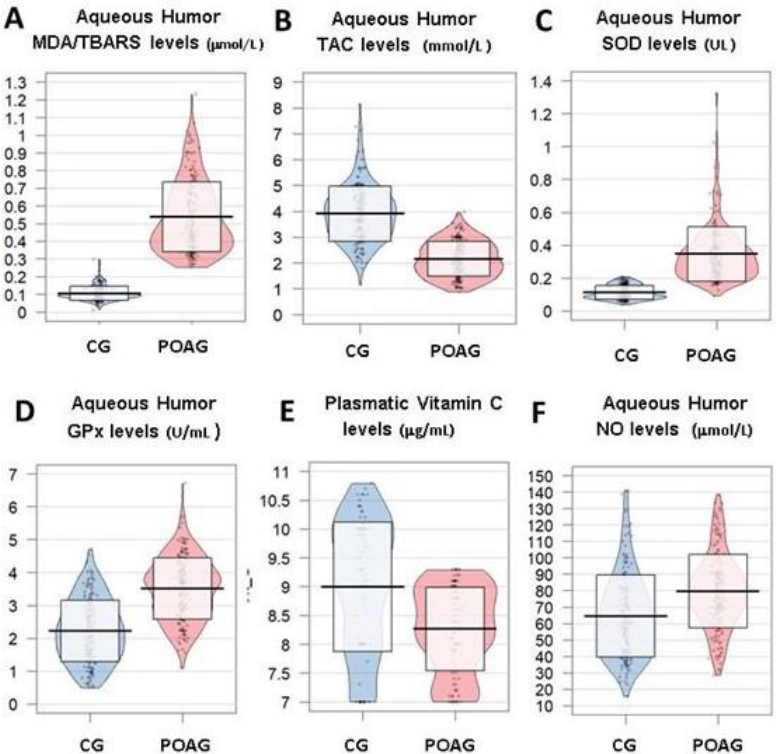
Figure 2. Oxidative stress markers in aqueous humor and plasma samples from the study participants. The OS overtime results in structural and functional eye damage. ( A ) Significantly higher MDA/TBARS expression levels (mol/L) in the aqueous humor from the POAG vs. the CG. ( B ) Significantly lower values of the TAC (nmol/L) in the aqueous humor from the POAG